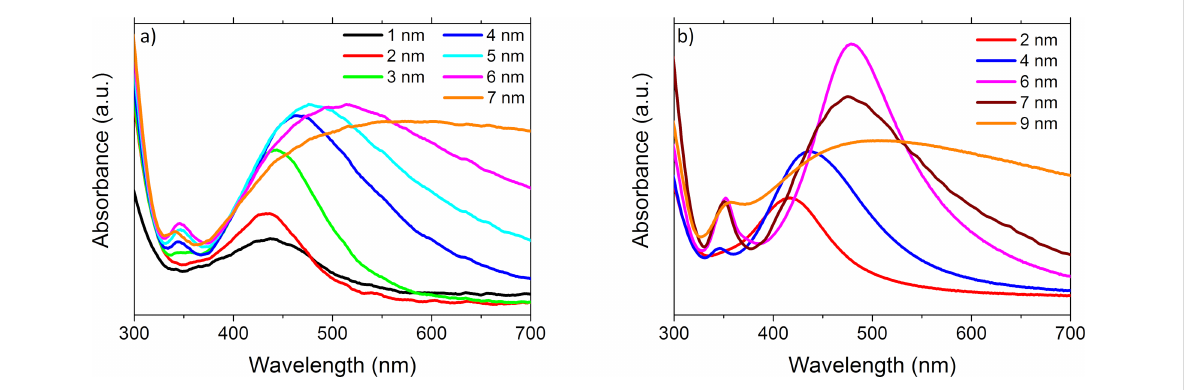
Figure 9: Absorbance of nanostructures formed from thin films with different thickness, annealed at (a) 250 °C and (b) 550 °C for 15 min.